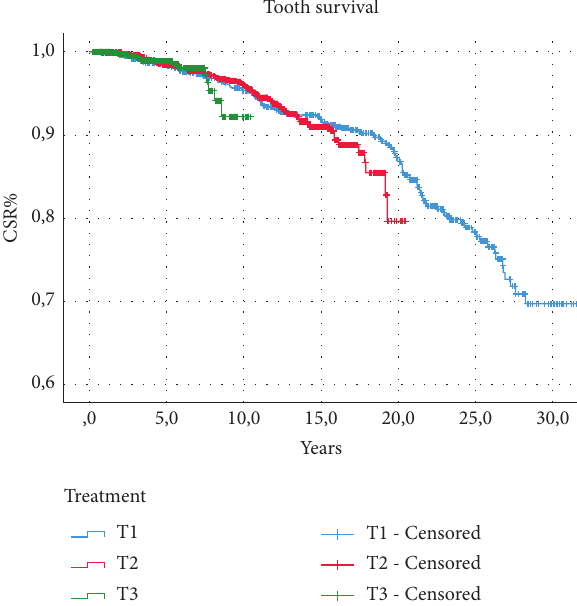
Figure 4: Survival function comparing different techniques (Kaplan–Meier).